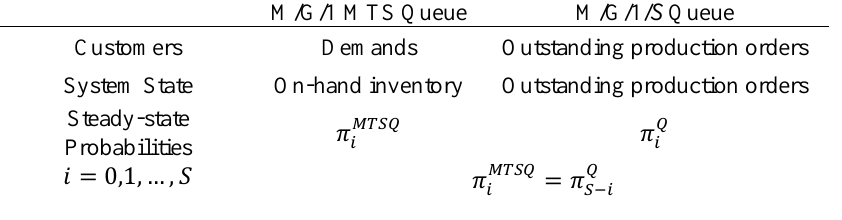
Table 1. The analogy between ‘M/G/1 MTS queue controlled by (𝑆 − 1,𝑆) ’ and ‘M/G/1/S